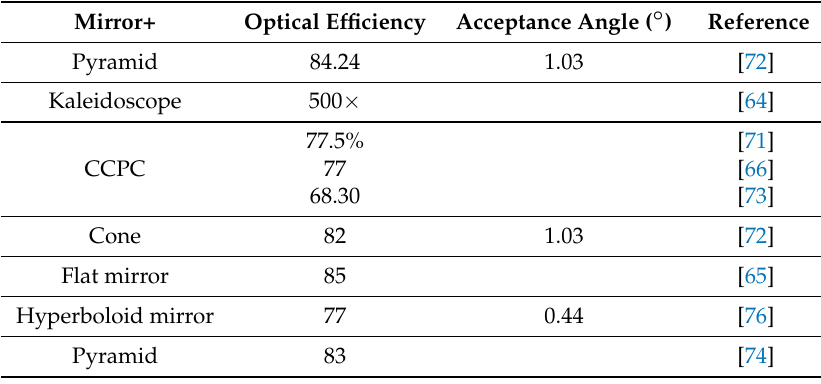
Table 5. Optical efficiency and acceptance angle for each optical